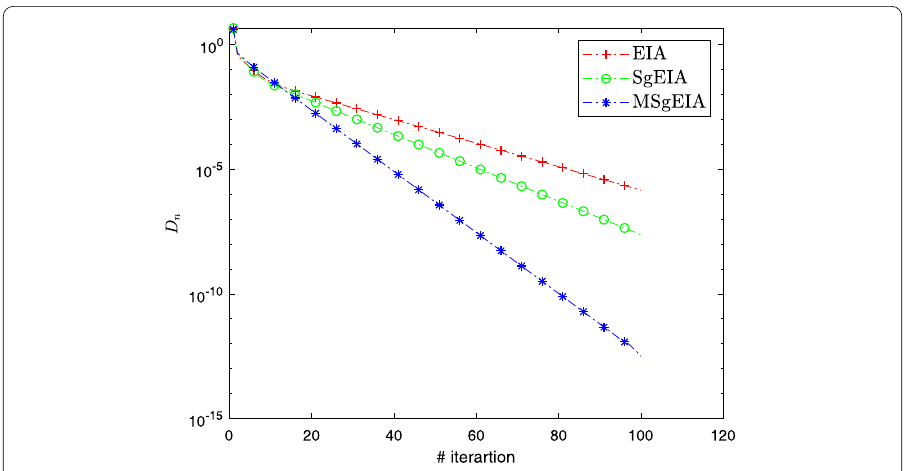
Figure 3 Experiment 5.1: Algorithm 2 comparison in terms of iterations